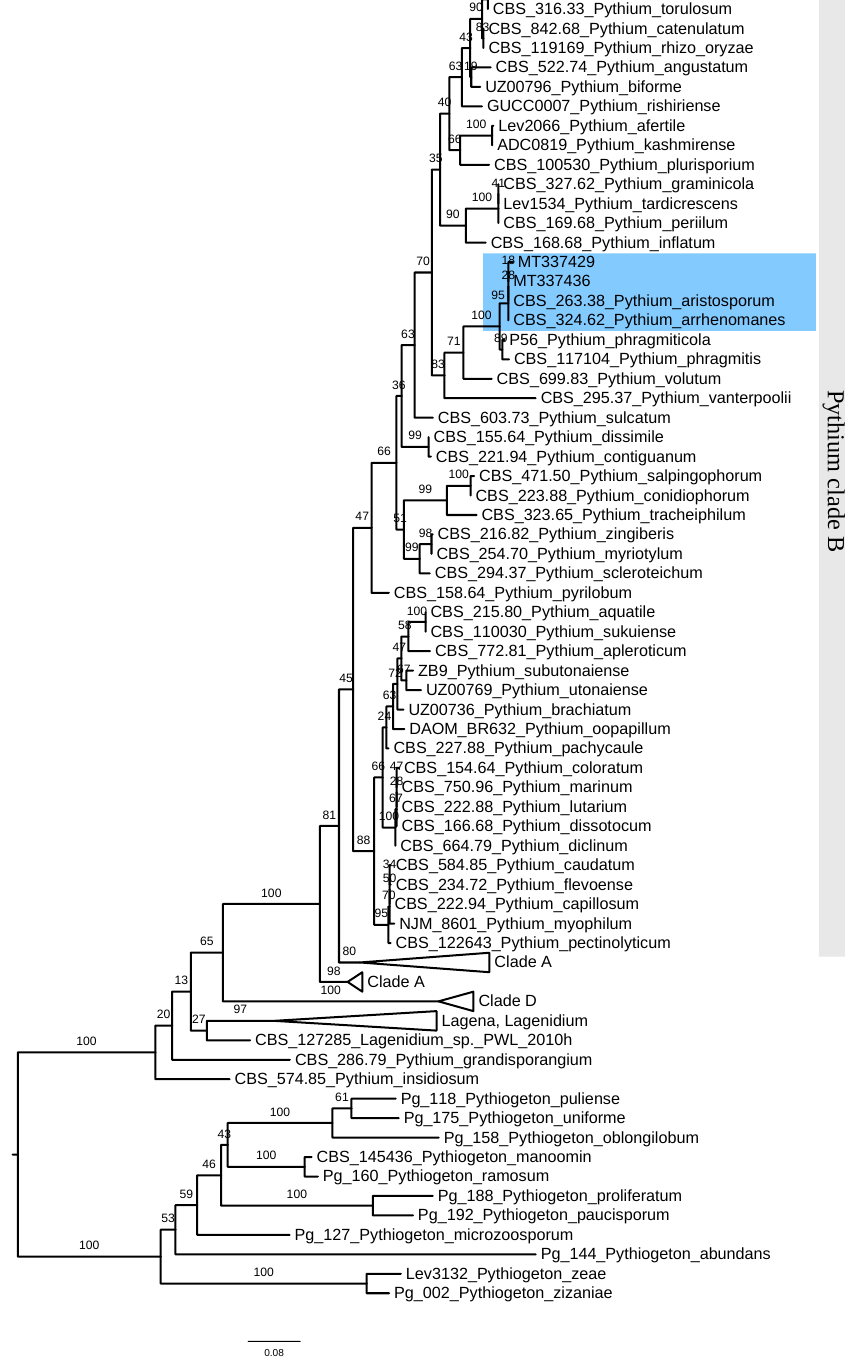
Figure 2. Phylogenetic tree of Pythium aristosporum strains JS22 and SH1 of rice seedling blight based on internal transcribed spacer regions (ITS) gene. The bootstrap values on the branching nodes were calculated on 1000 replications. The scale bar indicated 0.08 substitutions per nucleotide position.